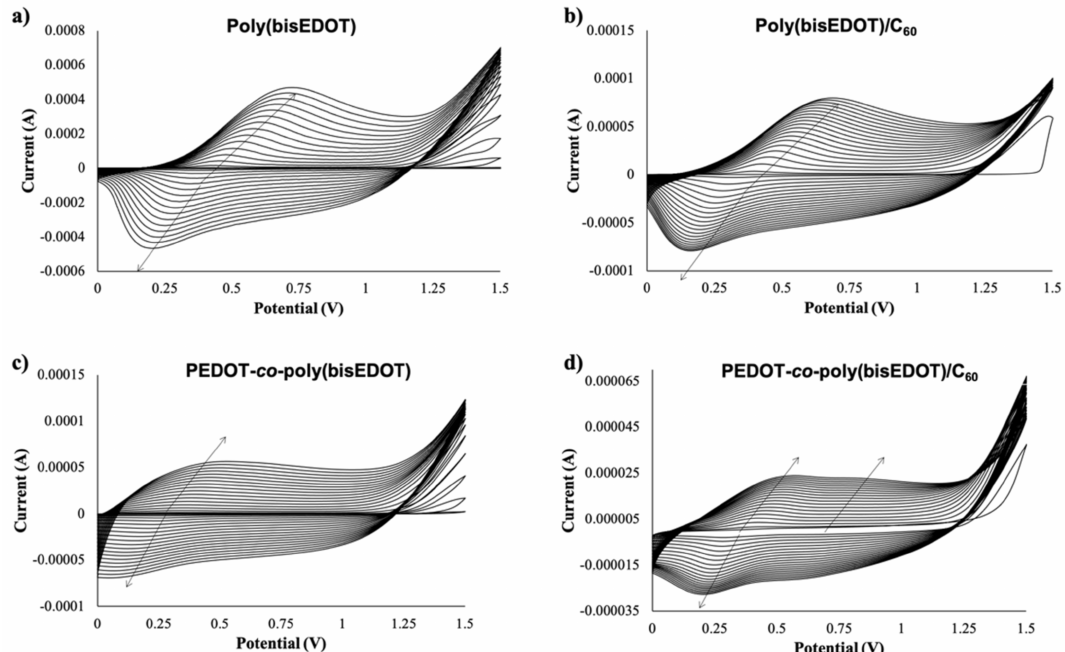
Figure 2. Cyclic voltammetry (20 scans, from 0 V to 1.5 V) for the electropolymerization and deposition of ( a ) bisP ( b ) bisP/C 60 , ( c ) PbisP, and ( d ) PbisP/C 60